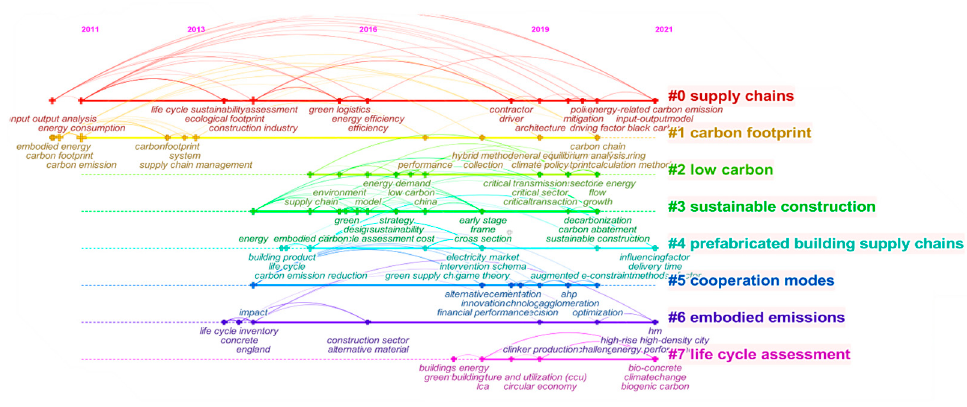
Figure 8. Clustering of the CLCSC.